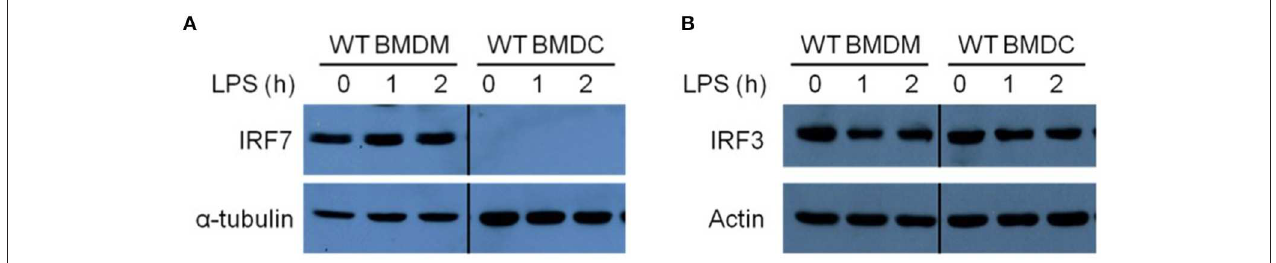
FIGURE 3 | Resting macrophages, but not DCs, constitutively express IRF-7 protein. Western immunoblot analysis of total IRF-7 (A) and total IRF-3 (B) protein expression in whole cell lysates of wild-type BMDMs and BMDCs, stimulated or not with 100ng/ml LPS for 0–2h. Data are representative of at least three independent experiments.